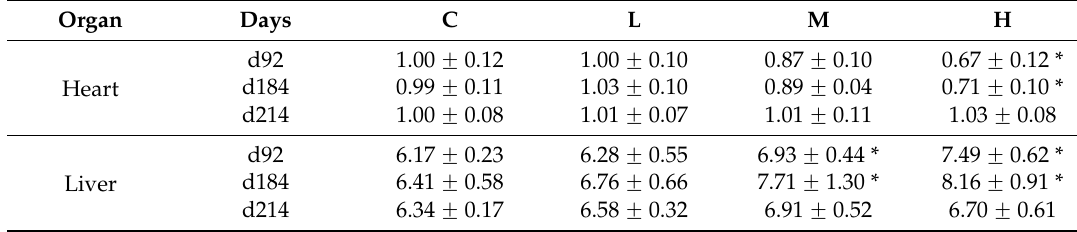
– x ˘ SD, d92 n = 5, d184 n = 10, d214 n =